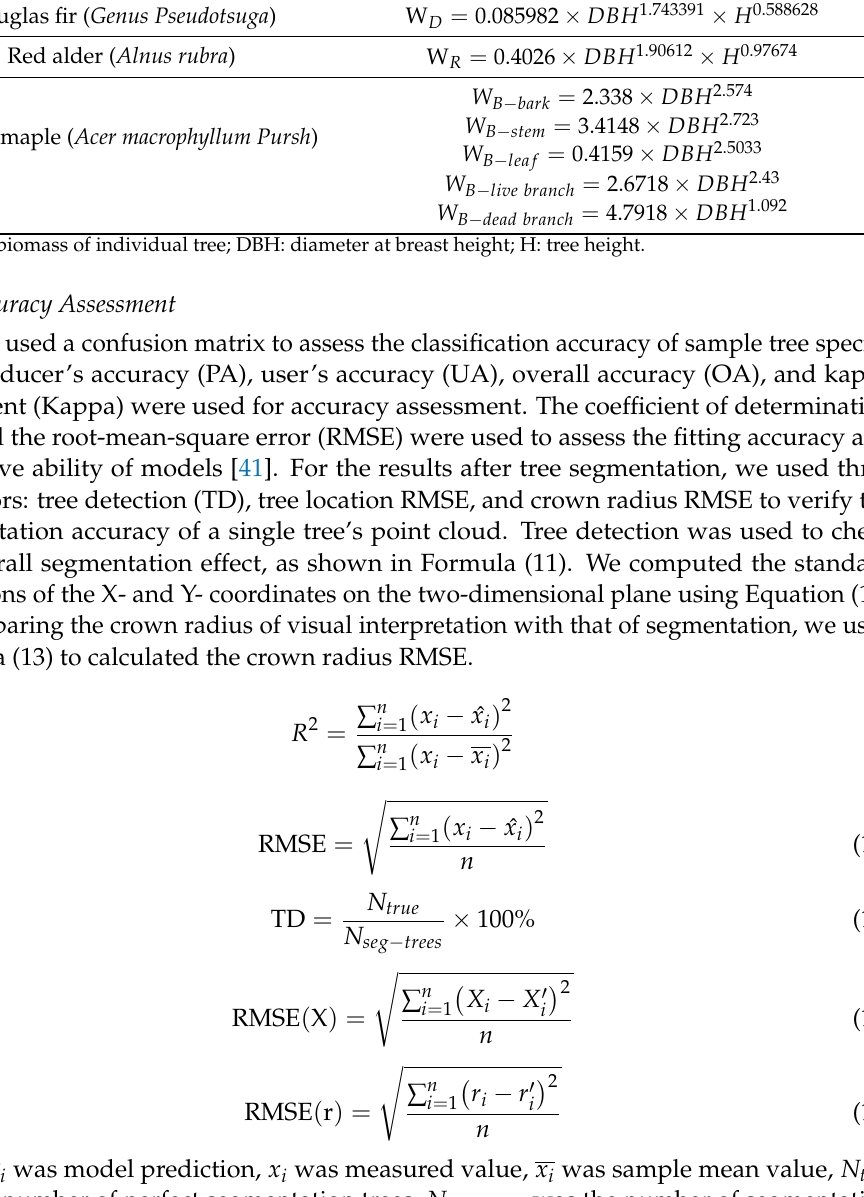
Table 4. Allometric equations of the tree species. Tree Species Allometric